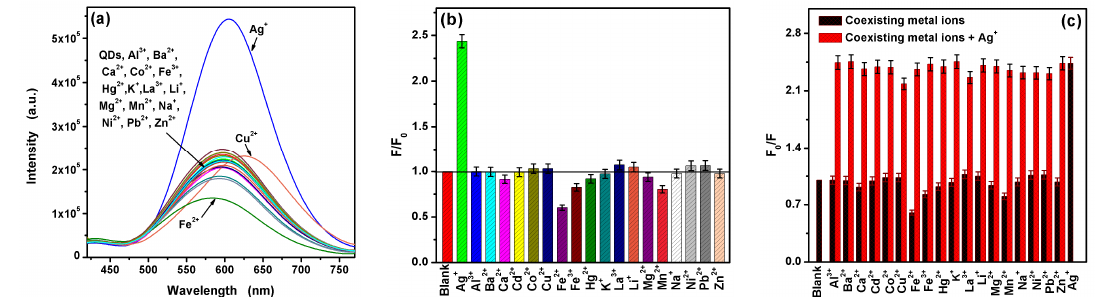
Figure 6. ( a ) Fluorescence spectra of L-Asp@CdS QDs in the presence of various cations ( b ) plots of relative fluorescence intensity (F 0 /F) in the presence of various cations and ( c ) selective fluorescence response of L-Asp@CdS QDs to 10 µ M Ag + (wine bars), and interference cations.